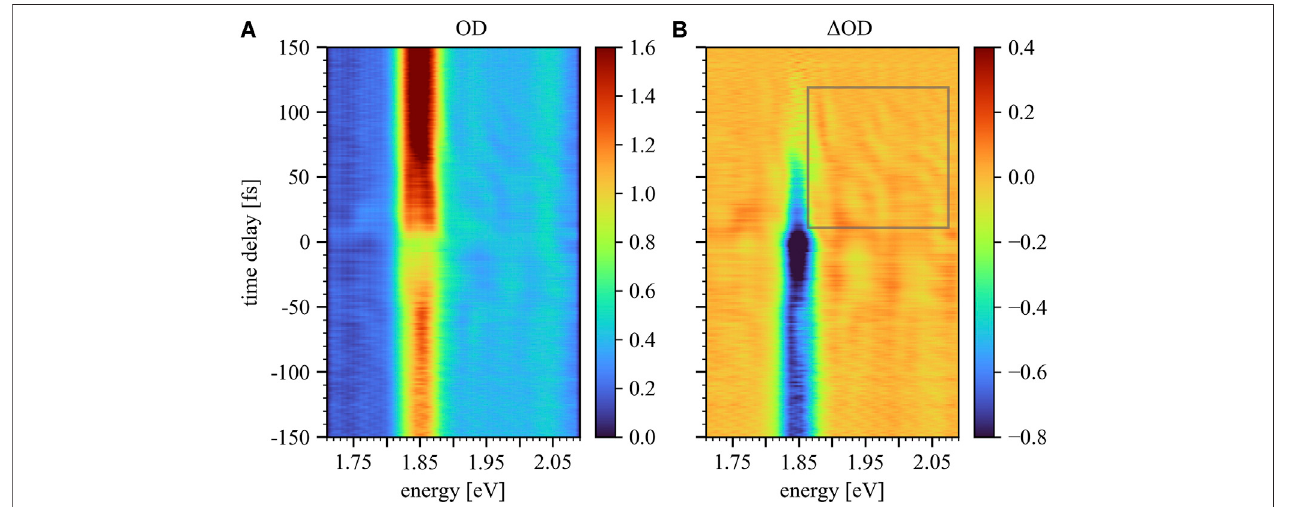
FIGURE5| Time-delaytraceOD ( ω , τ ) (A) and Δ OD ( ω , τ ) (B) ofAlClPccomplexesdissolvedinethanol.The Δ OD (B) underlinesthecontrol-inducedchangesofthe excitation-pulse induced dipole response in AlClPc. Faint rapid fringes along the time-delay axis are due to residual stray light of the control beam which optically interferes with the excitation beam and occur symmetrically for both positive and negative times. At negative/positive times, the control pulse arrives before/after the excitationpulse,wherethelatteriscenteredattime t (cid:1) 0andinducesacoherentdipoleresponsefortimes t > 0.Thegreyboxmarkstheareaofinterestwhereslow spectro-temporal modulations of the measured absorption are visible. The color bars represent the magnitude of OD.